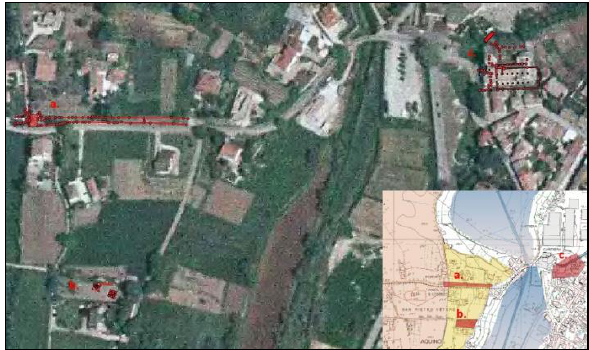
Figure 5. GPS survey, screenshot of the GIS, basemap ortophoto Regione Lazio 1:2000: a) Porta San Lorenzo and Via Latina; b) Excavations of Madonna degli Angeli Church; c) Santa Maria della Libera Church and Marco Antonio's Arch (D'Urso et al., 2017).